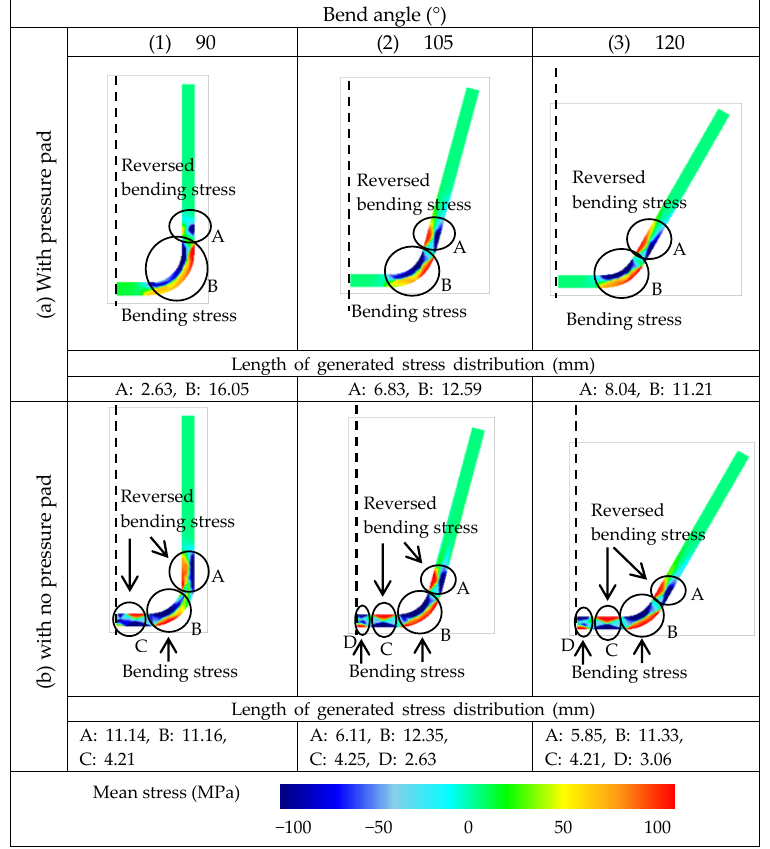
Figure 8. Comparison of the stress distribution analyzed in the workpiece, before unloading, with respect to various bend angles ( R p : 7 mm, W : 30 mm, t : 3 mm, WP L : 120 mm, R ud : 5 mm).